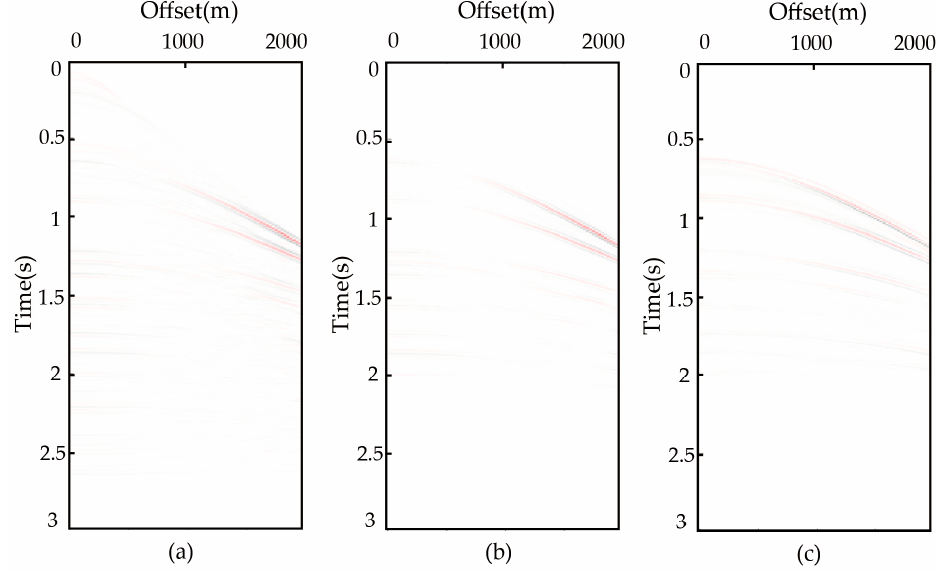
− 𝐿 (cid:3044) . (cid:3117) (cid:3118)